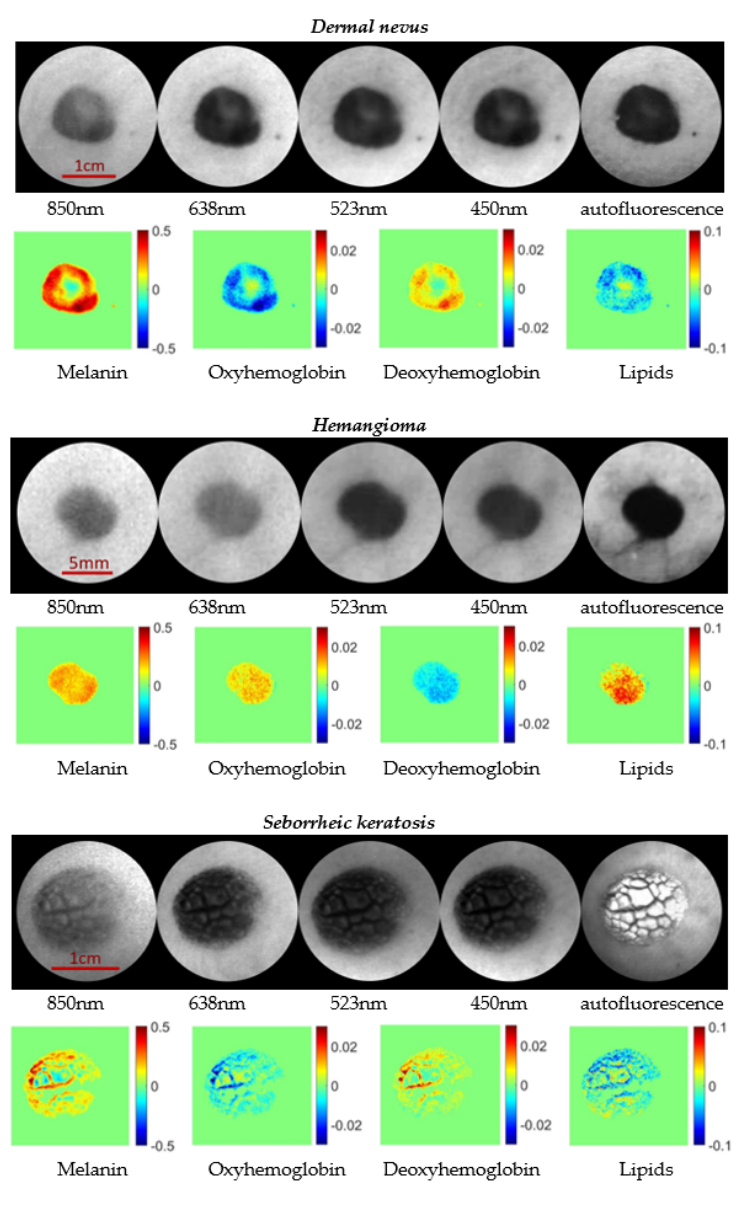
Figure 7. Spectral line and autofluorescence images of three skin malformations taken by the prototype device with the correspondingly calculated chromophore distribution maps. Units of the concentration increase / decrease are mili-moles for the first three chromophores and moles for lipids. To conclude, the initial test data are in general agreement with the data obtained in previous multi-spectral skin imaging studies [5,12,23,24] and confirm the potential of the proposed device for non-contact assessment of various skin